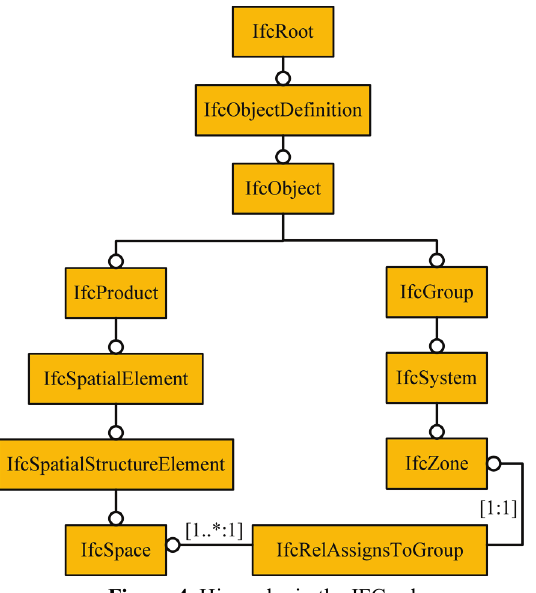
Figure 4. Hierarchy in the IFC schema.